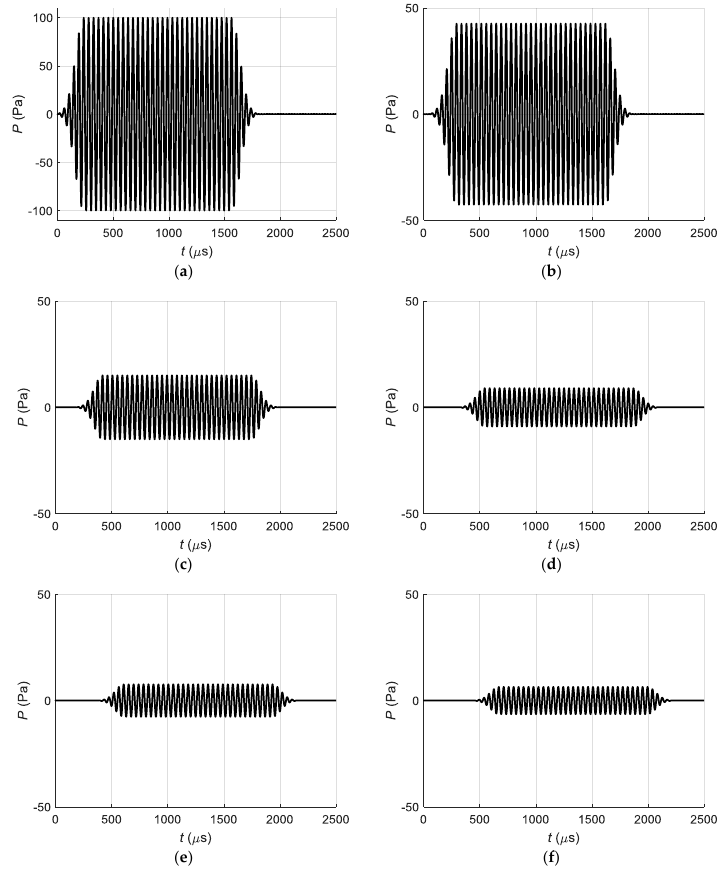
Figure 14. Partial acoustic pressure signals P at the point P P , generated by different array elements: ( a )—element 8; ( b )—element 7; ( c )—element 5; ( d )—element 3; ( e )—element 2; ( f )—element 1.